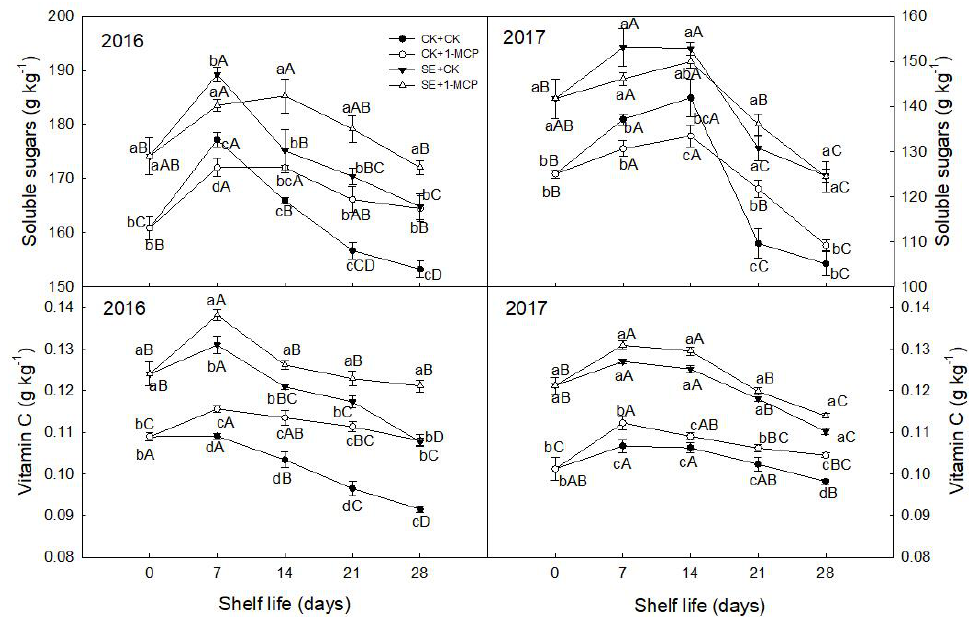
Figure 4. Dynamic changes in soluble sugars and vitamin C during shelf life period. Notes: CK—control treatments; SE—Se fertilizer treatments; 1-MCP—1-methylcyclopropene treatments; Vc, vitamin C. Different lower-case letters on the polyline show significant differences ( p < 0.05) between different treatments. Different capital letters on the polyline show significant differences ( p < 0.05) between different shelf life (days).